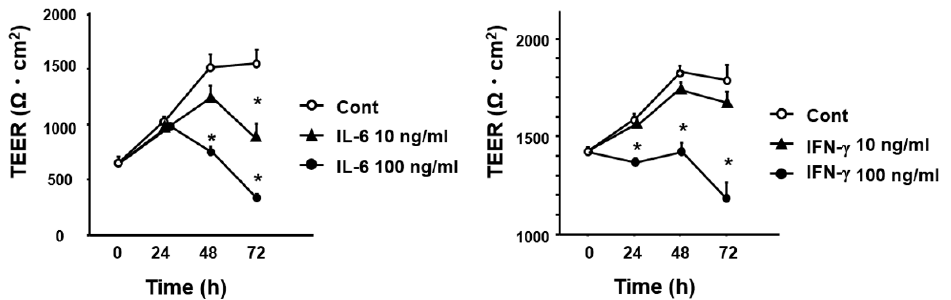
Figure 6. Effect of IL-6 and IFN- γ stimulation on transepithelial electrical resistance (TEER). Caco2 cells were treated and stimulated with recombinant IL-6 ( n = 3) or IFN- γ ( n = 3) at indicated concentration as described in Materials and Methods. Significantly lower than the level in untreated controls at the same timepoint; * p < 0.05.